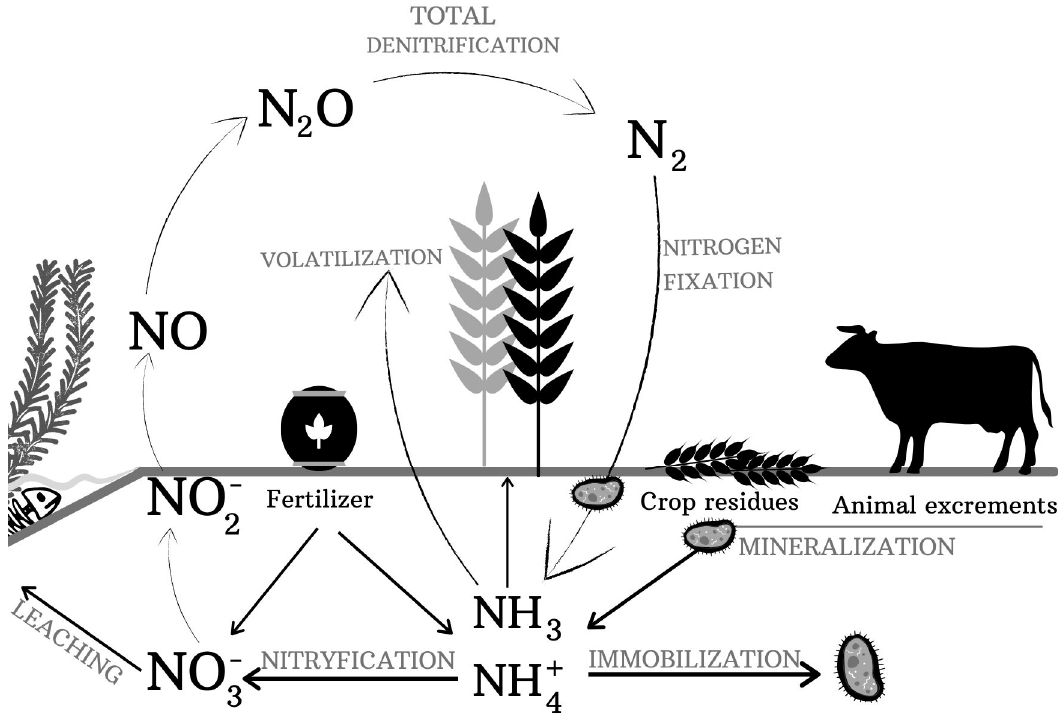
Figure 1. Nitrogen transformations in soil. Source: Authors’ original compilation. Proteolysis is the first stage in the decomposition of nitrogen-based organic